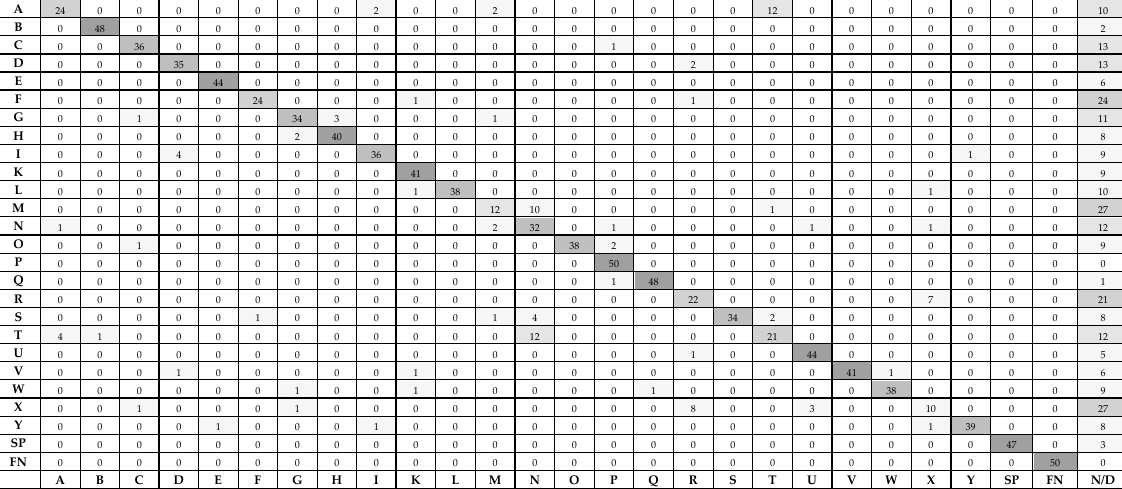
Figure 12. YOLO model A2 (352 × 352) confusion matrix.